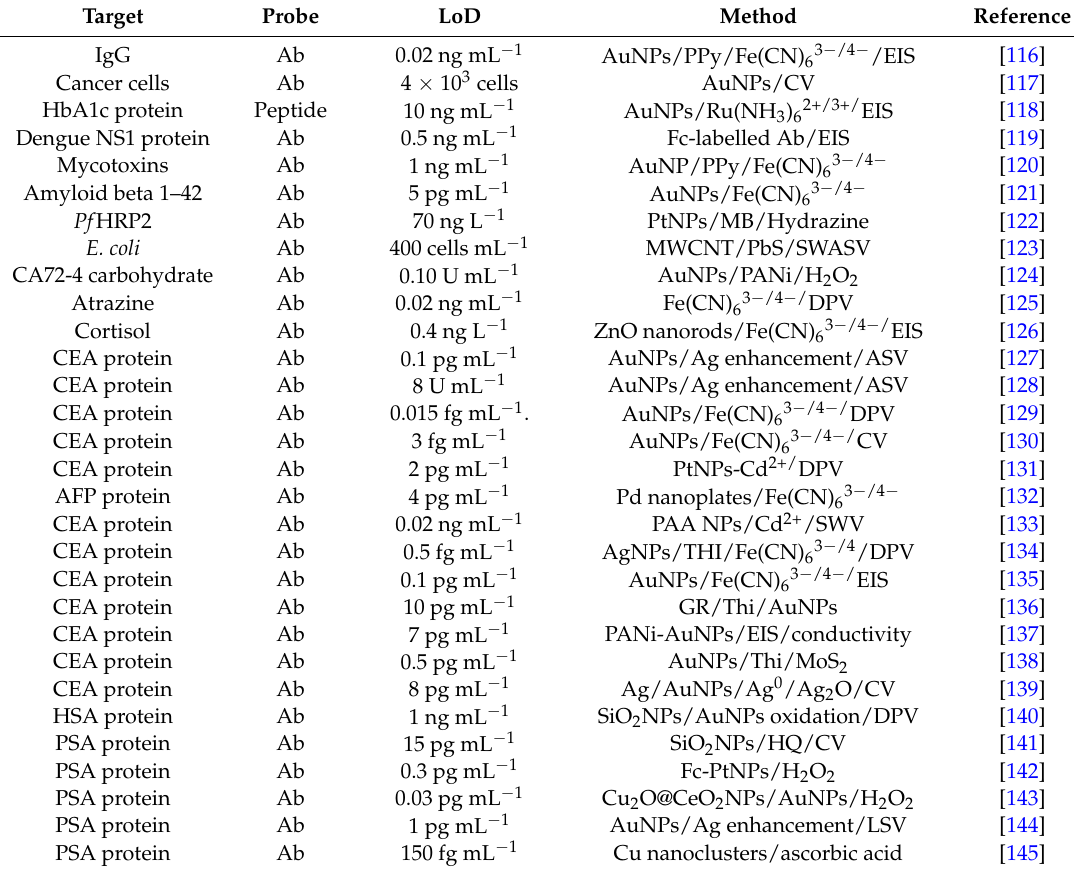
Table 8. Figures of merit of selected non-enzymatic immunosensors using metal or metal oxide nanoparticles.